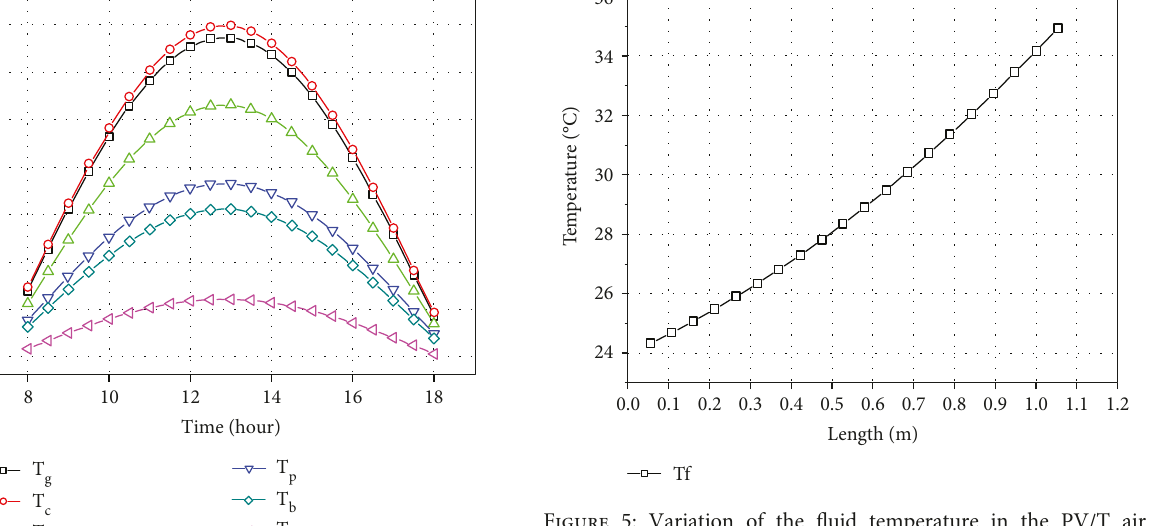
Figure 5: Variation of the fl uid temperature in the PV/T air collector.